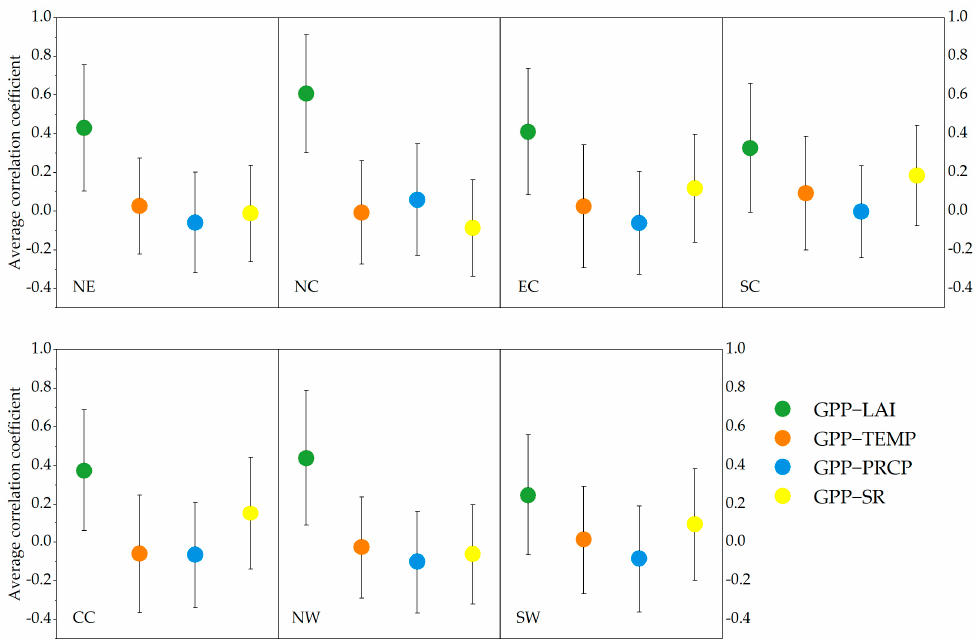
Figure 11. Average correlation coefficients and standard deviations of the GPP with LAI, TEMP, PRCP and SR correlations in the different regions.